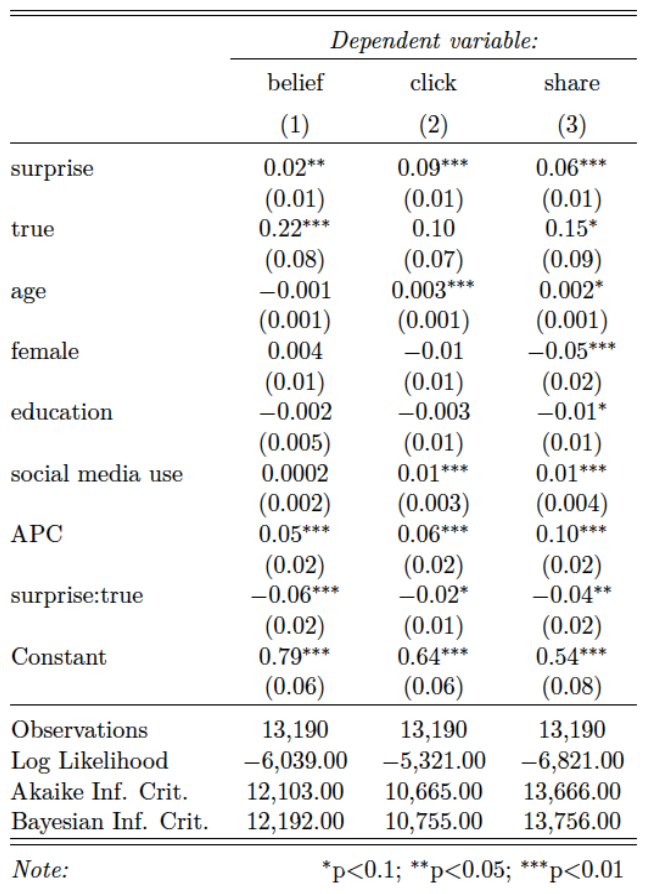
Table C5. Predicting outcomes with controls: